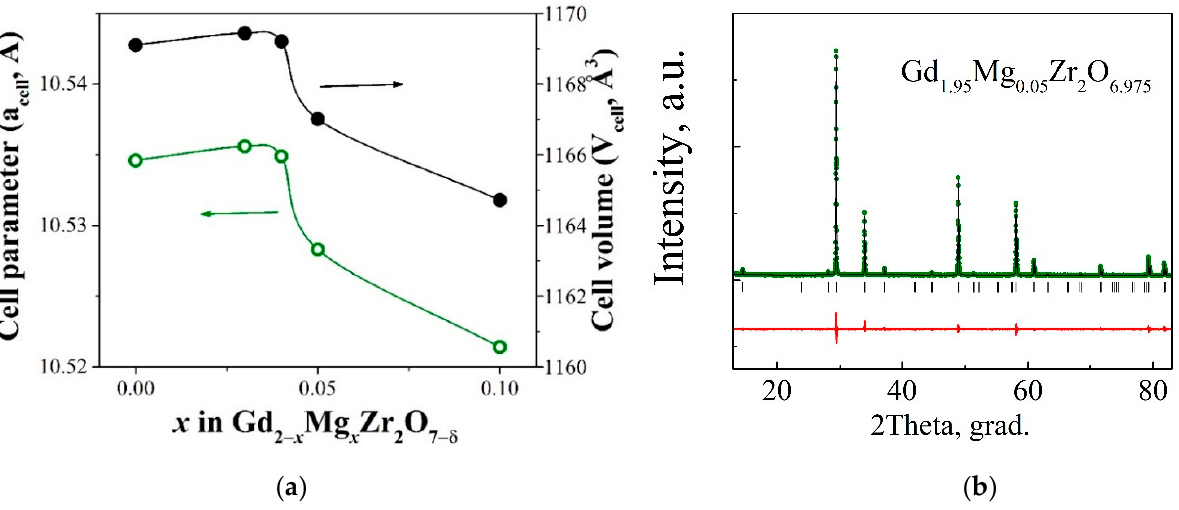
Figure 4. Concentration lattice parameter and cell volume dependencies for the solid solution Gd 2 − x Mg x Zr 2 O 7 − x/2 ( a ). Rietveld refinement XRD pattern of Gd 1.95 Mg 0.05 Zr 2 O 6.97 . Green dots are the experimental data, black line is the calculated data, black ticks are the peak positions of pyrochlore structure with space group Fd-3m, the red line is the difference between the calculated and the experimental data (R p = 3.57, R wp = 5.06, R exp = 4.28, χ 2 = 1.39) ( b ). Table 2. The site occupancies for Gd 2 − x Mg x Zr 2 O 7 − x /2 in a cubic unit cells with the space group Fd-3m.